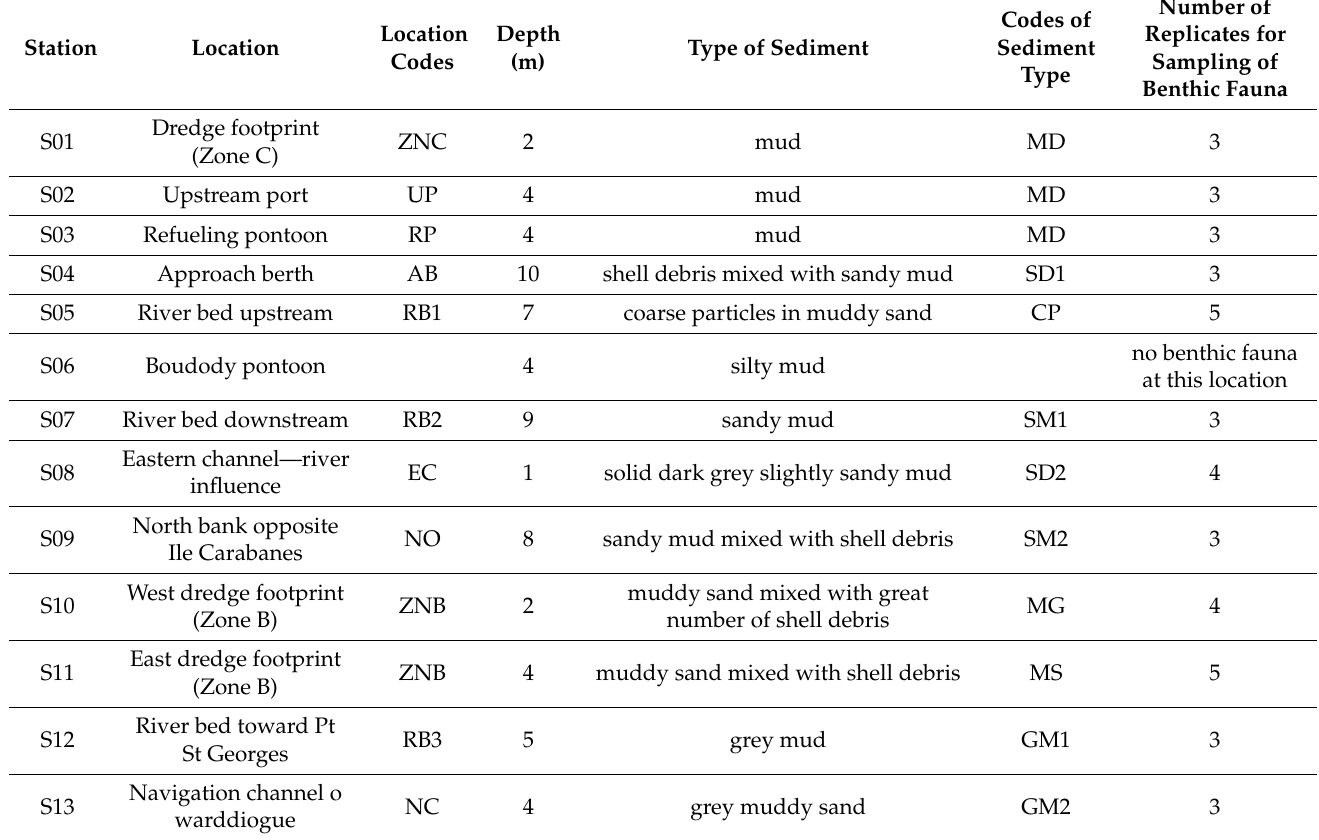
Table 1. Description of sampling sites and replicates used for benthic fauna